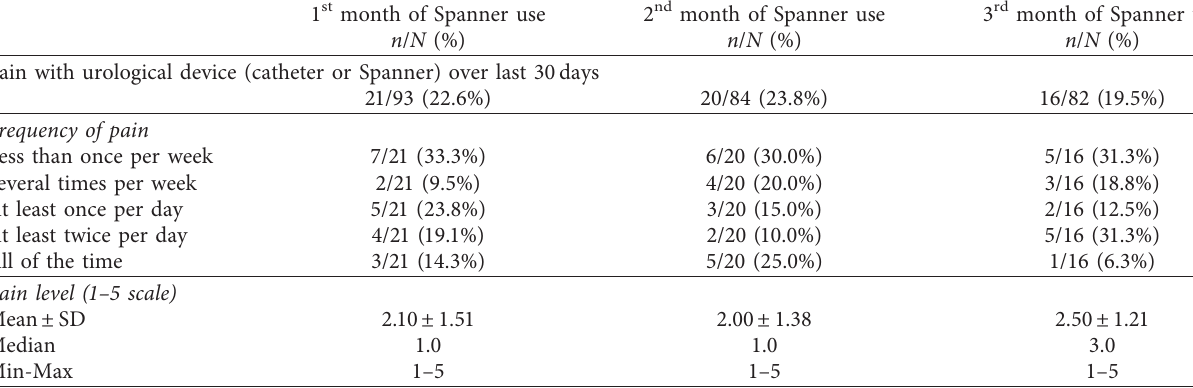
Table 5: Pain assessment.